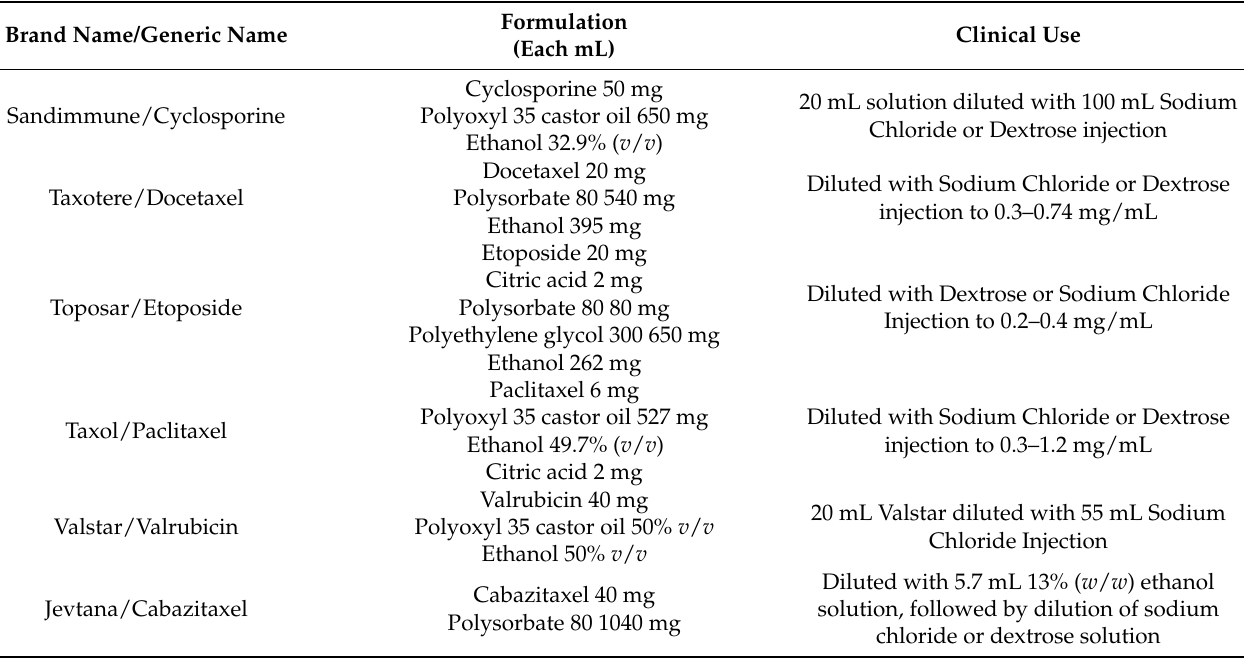
Table 1. Market formulations solubilized by the combination of surfactants and